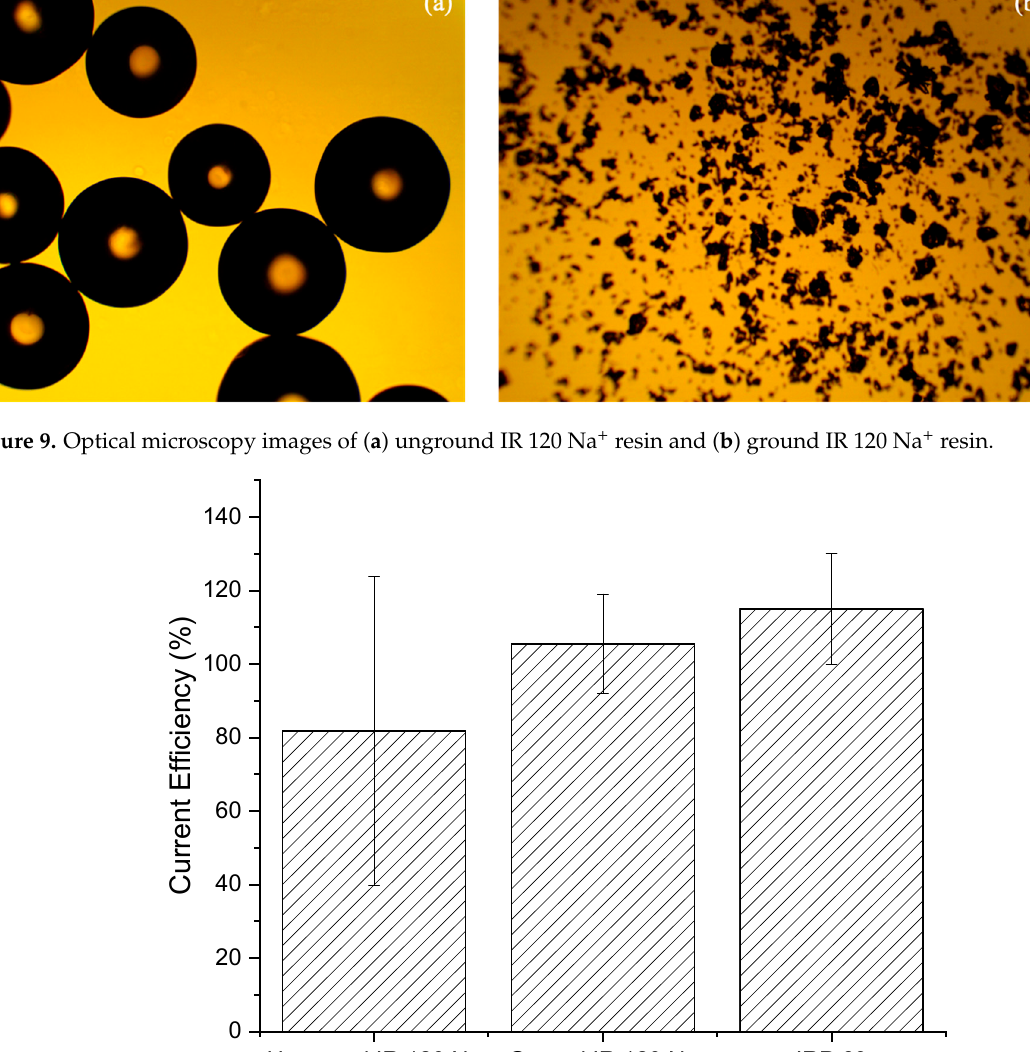
Figure 10. Current efficiencies for unground bead form IR 120 Na + and ground IR 120 Na + .